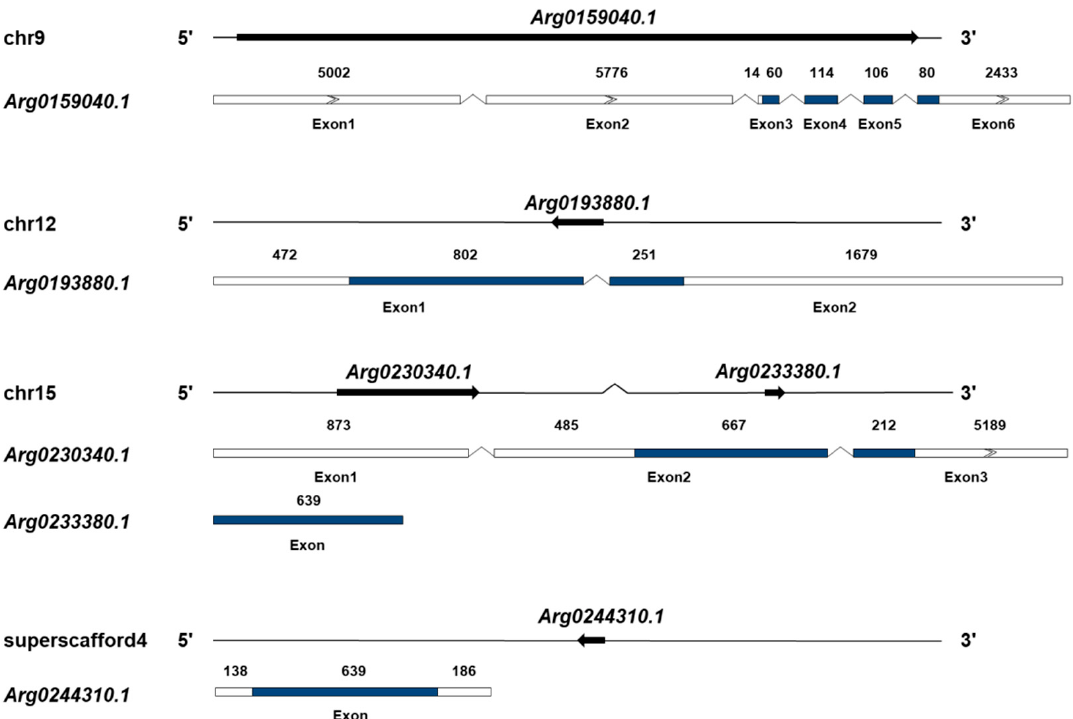
Figure 1. Genomic structure of AiPC4 genes. The genomic structures of AiPC4s were determined by mapping cDNA sequences to genomic DNA sequences. The five AiPC4s are distributed into three chromosomes and one scaffold. The arrows on the lines indicate the genes located in the scaffolds. Exons in the ORF are displayed as colored boxes, 5 ′ and 3 ′ UTRs are represented by uncolored boxes, and introns are represented by broken lines. The lengths of the 5 ′ and 3 ′ UTRs and exons are relative to the cDNA sequence’s length. The number above each exon presents the exon length (bp). Table 1. Sequence features of AiPC4s from bay scallop A. irradians .